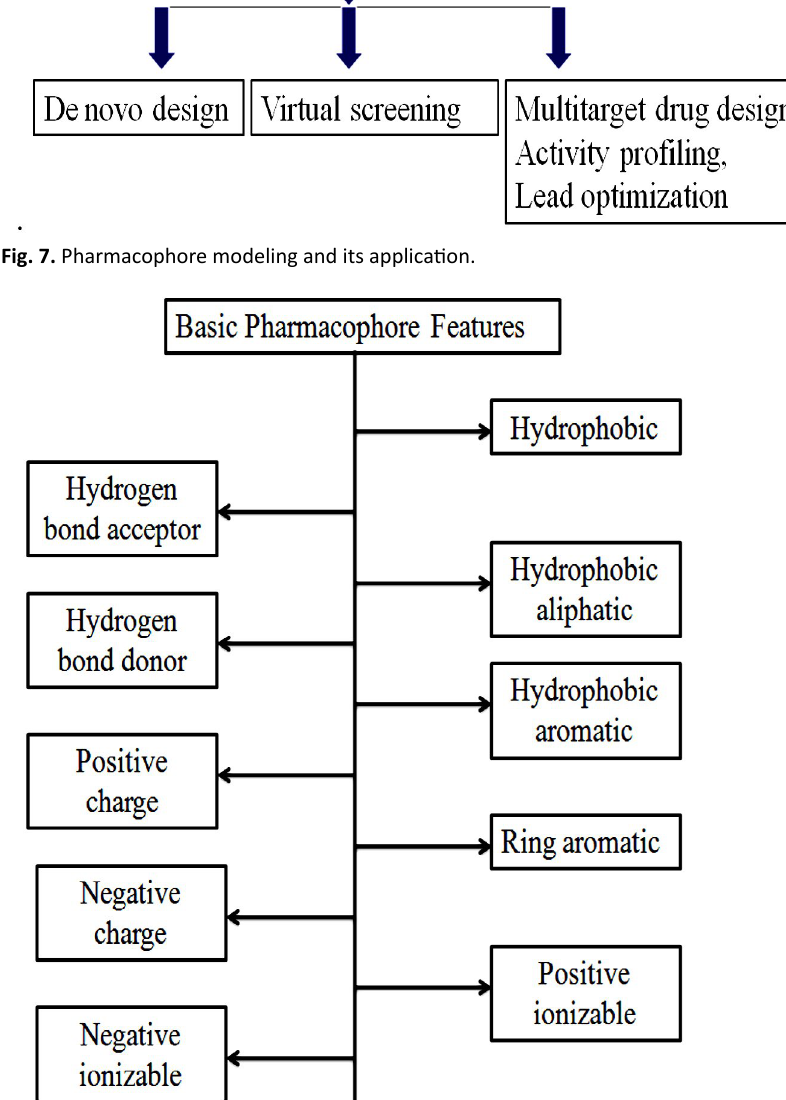
Fig. 8. Basic Pharmacophore features of a molecule.